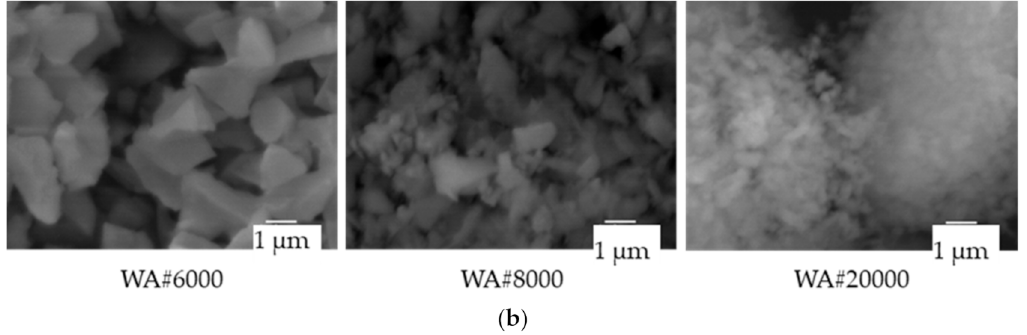
Figure 14. SEM images of the workpiece surface and abrasive particles. ( a ) Workpiece surface; ( b ) Abrasive particles.